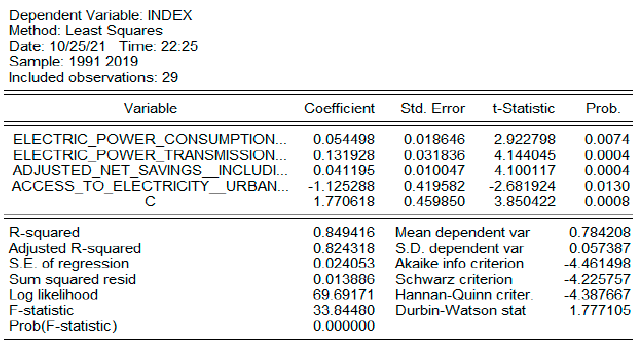
Figure 15. Eviews linear regression assessment output.